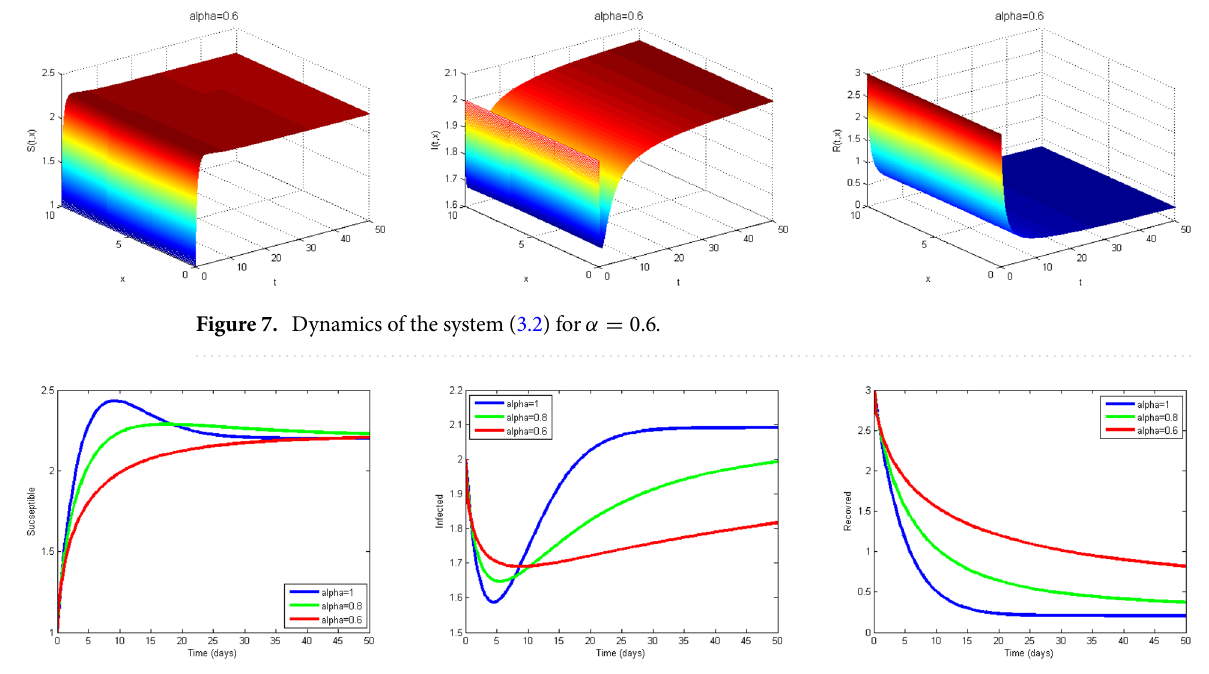
Figure 8. Dynamics of the system (3.2) for x fixed and for α = 0.6, 0.8, 1 in the case where R 0 = 2.0455 > 1 .